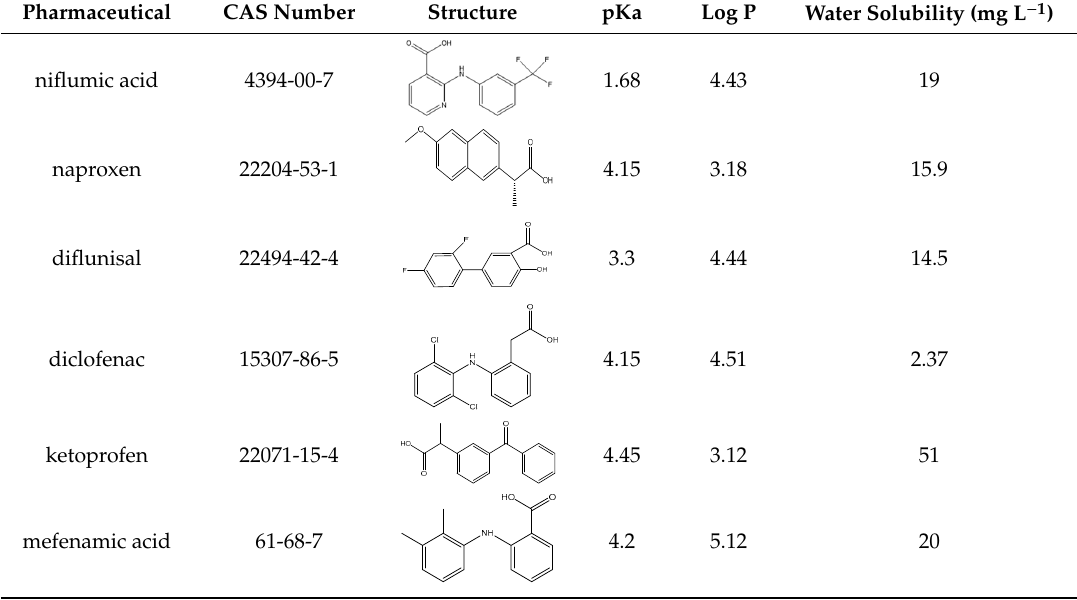
Table 2. The physical properties and structures of selected NSAIDs.